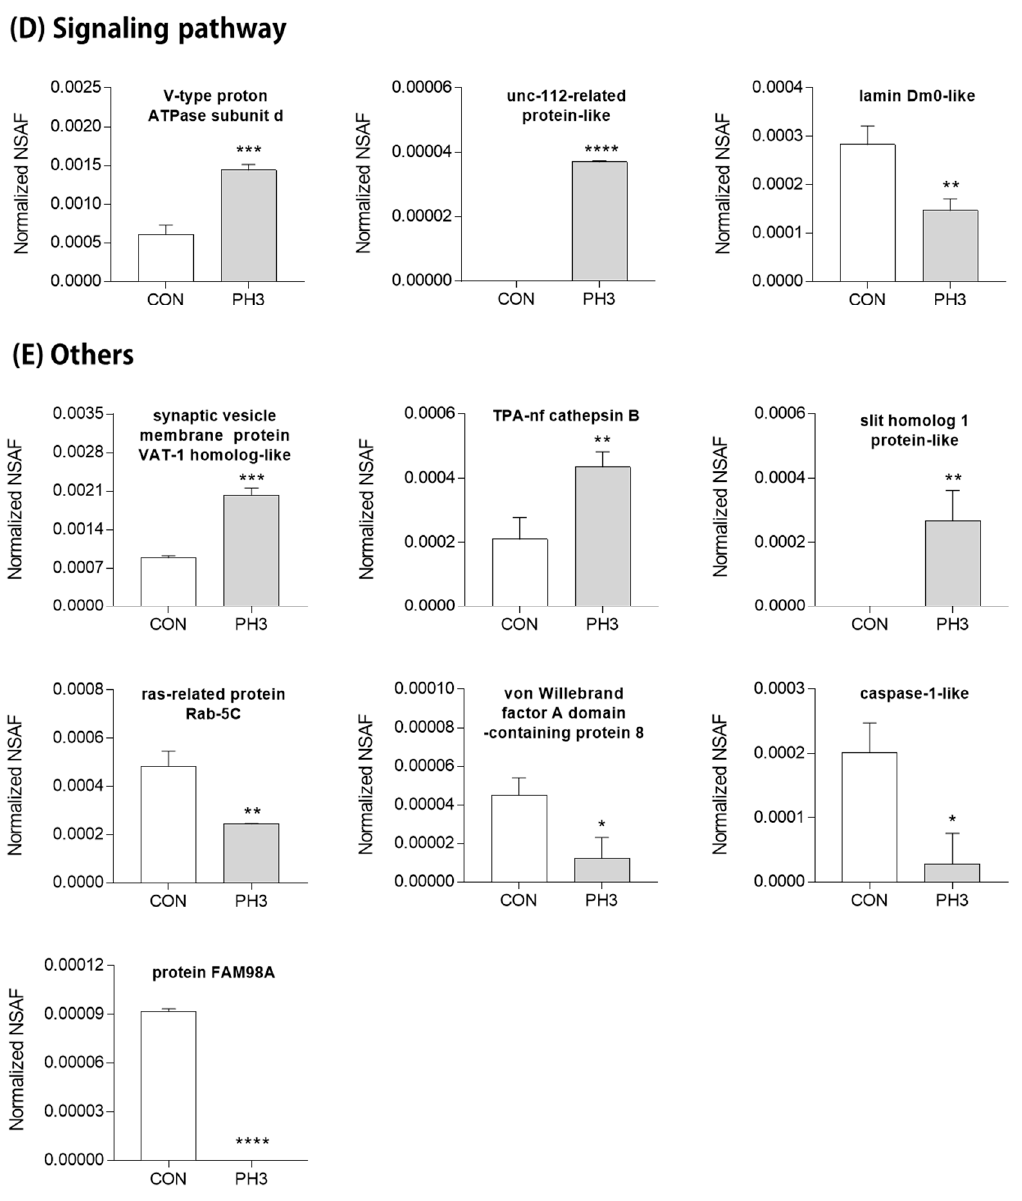
Figure 5. Proteins differentially expressed in adults of Myzus persicae after phosphine treatment at the concentration of 0.5 mg/L for 4 h. CON; control treatment group, PH3; phosphine treatment group. Statistically difference was analyzed using t -test ( p < 0.05). *, <0.05; **, 0.01; ***, 0.001; ****, 0.0001. ( A ), proteins classified in chromatin and histones; ( B ), proteins involved in transcription; ( C ), proteins involved in translation and post-translational modification; ( D ), proteins involved in signaling pathways; ( E ), other proteins.